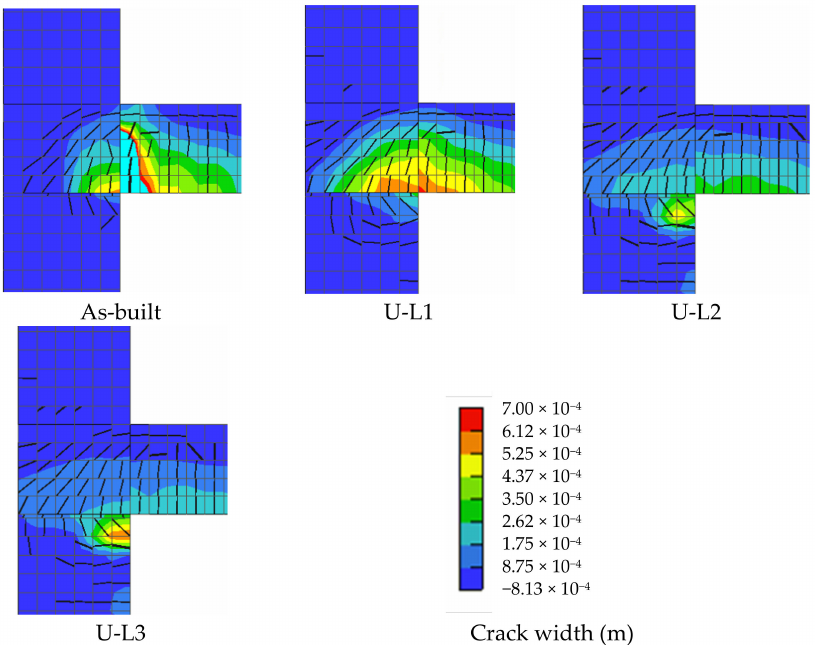
Figure 8. Crack patterns of CFRP and as-built specimens at 4%